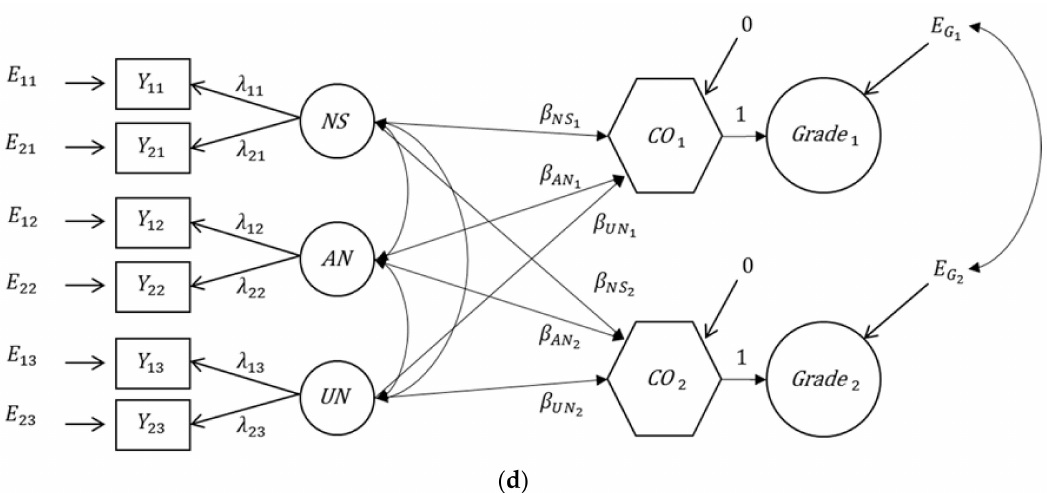
Figure 2. Modell with correlated first-order factors. ( a ) Model without criterion variables, ( b ) model with correlating criterion variables, ( c ) multiple latent regression model, and ( d ) multiple latent regression model with composite factors. F k : facet factors, E ik : measurement error variables, NS : facet factor number series, AN : facet factor verbal analogies, UN : facet factor unfolding, CO 1 /CO 2 : composite factors, E G1 / E G2 : residuals λ : loading parameters, β : regression coefficients, i : indicator, k :